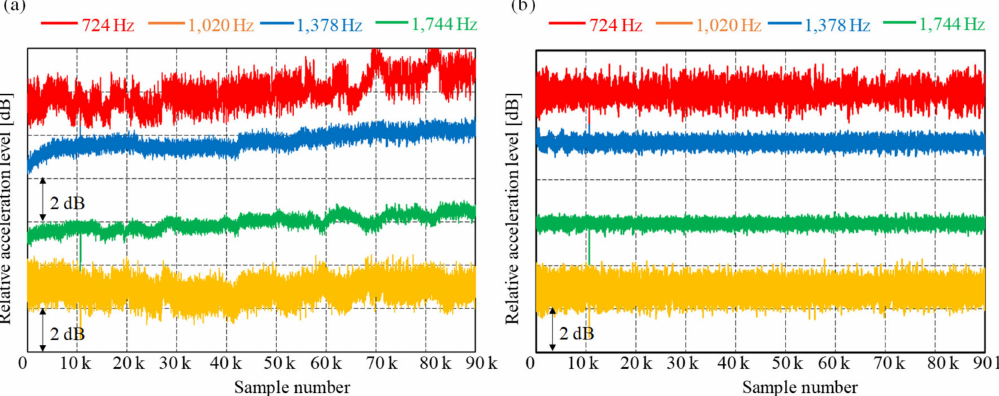
Figure 19. Time-series data of the vibration in the normal conditions ( a ) without high-pass filtering and ( b ) with high-pass filtering: Since some trends in the time series of these energy levels in the respective bands were apparent, the periodic components of these series were investigated using the results of FFT processing, and will be removed by filtering.